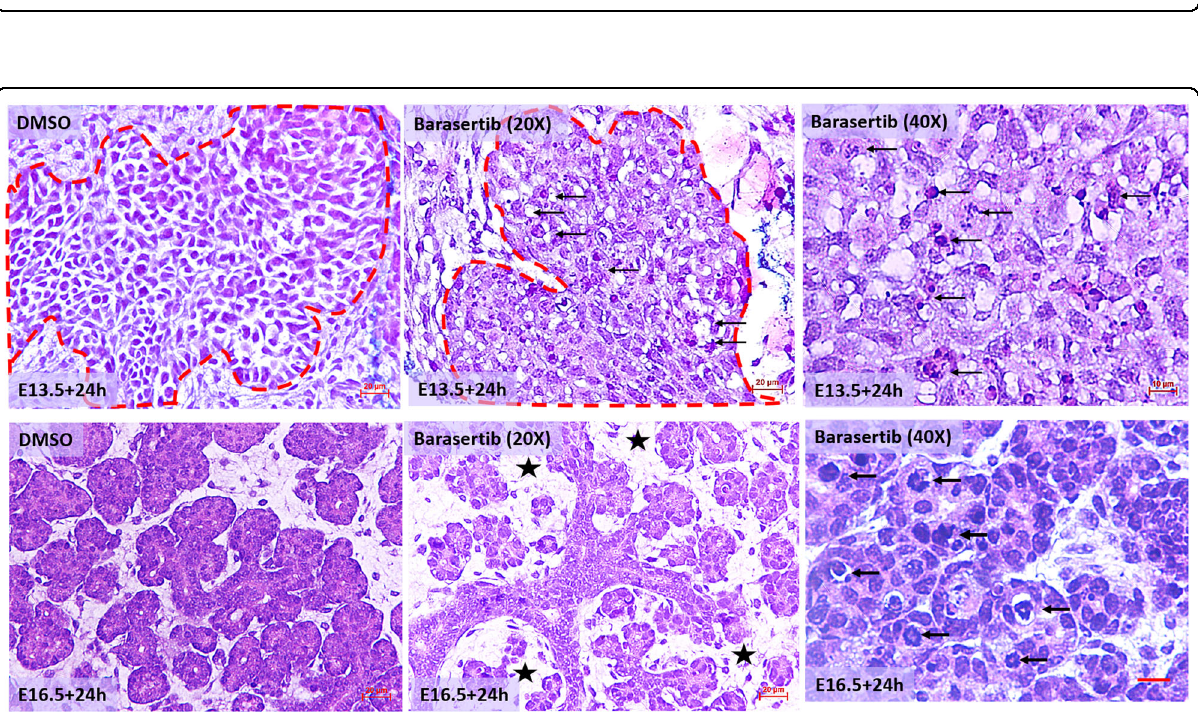
Fig. 3 Impact of Barasertib (1 µM) on explant expansion compared to the cell cycle inhibitor Aphidicolin (500 ng/ml). Both inhibitors arrested growth of the SMG explants to the same extent (a, b), analysed by two-way ANOVA, *** P ≤ 0.001, ns: non-signi fi cant p > 0.05, n = 3 for each group.